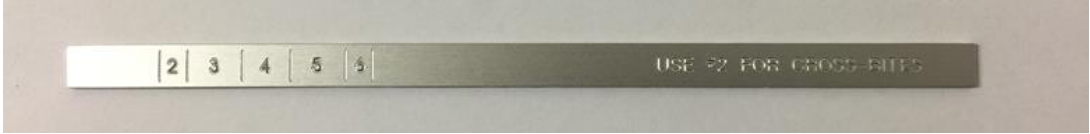
Figure 11. Our “elastic selector gauge”.